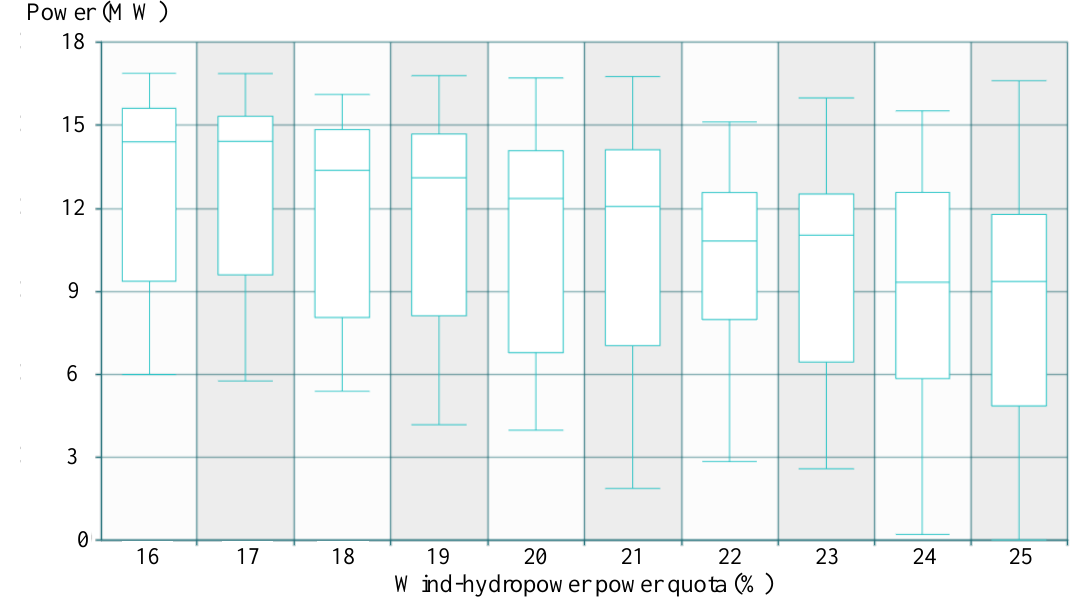
Figure 13. Box plot of the hydraulic power fluctuation under different wind-hydropower quota scenarios. The “W” is the short for the unit of hydraulic power, and the “%” is the short for the unit of energy quota.